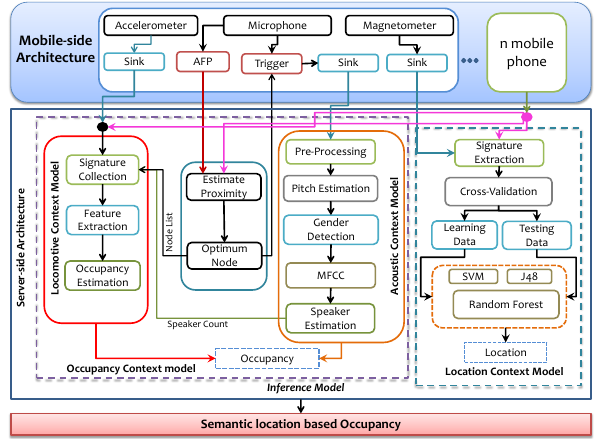
Figure 1: Architectural Overview of our